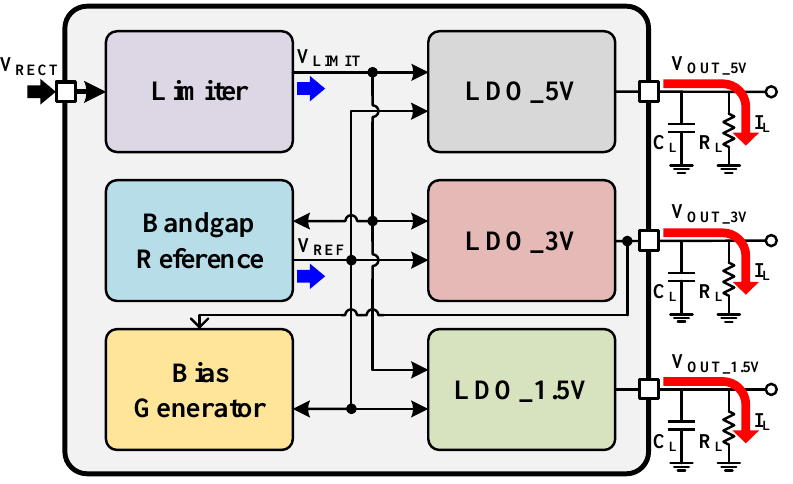
Figure 1. Block diagram of the proposed power regulated circuit